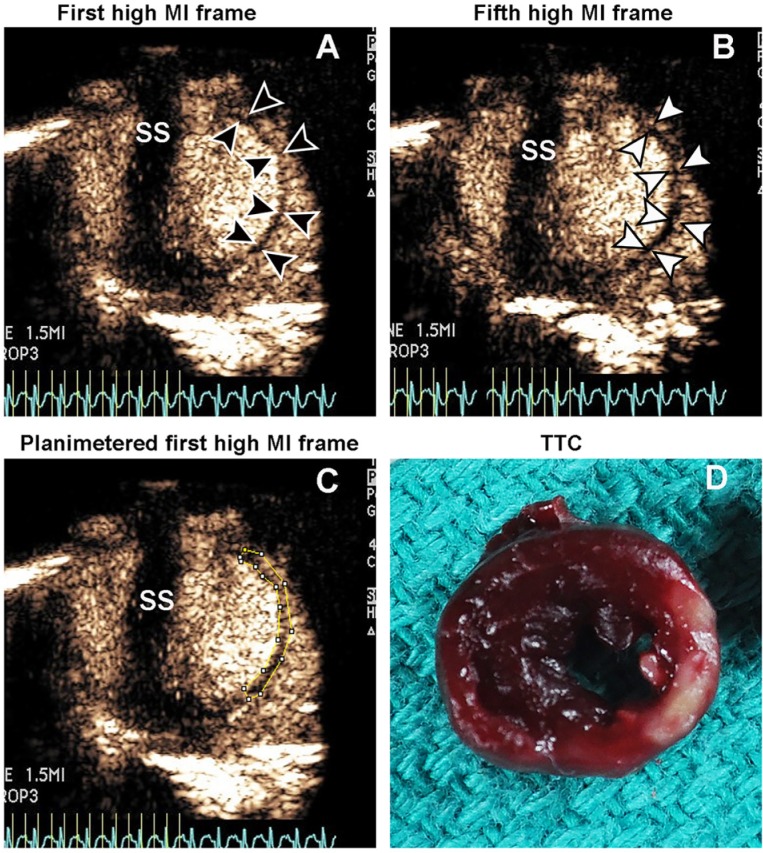
Two minutes post intravenous injection of definity droplets, myocardial and cavity enhancement are observed when the MI is increased to 1.5 (Panel A). After five frames at this high MI, a decrease in contrast is observed in the transient enhancement zone (TEZ), with endocardial and epicardial borders delineated in Panels A and B. The size of the TEZ is planimetered in Panel C, and the corresponding infarct zone is demonstrated by TTC staining in Panel D. IVI = intravenous injection; SS = sternal shadow.